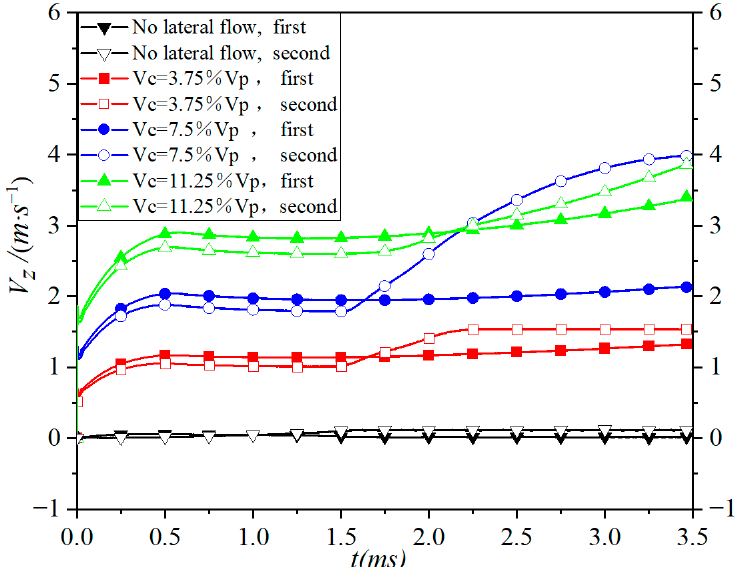
Figure 19. The change in the velocity in the z-direction with the time. Under the condition with the lateral flow velocity of 11.25% V p , the offset velocities of projectile 1 and projectile 2 are larger than those under other conditions before t = 2.25